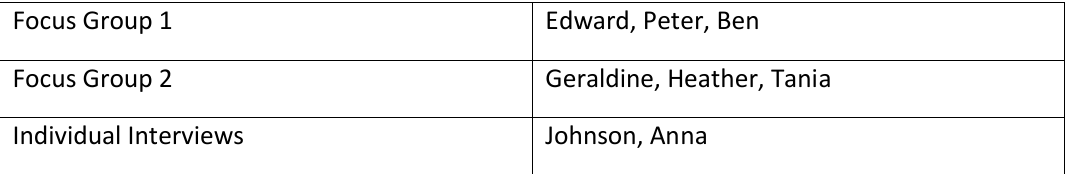
Table 3: interviewees Focus Group